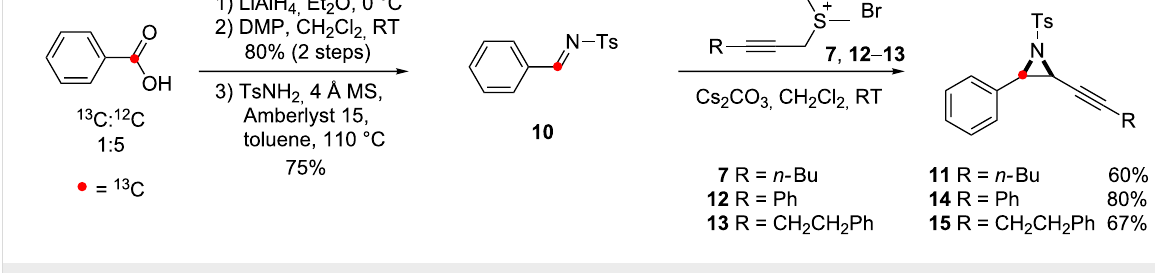
Scheme 6: Preparation of 13 C-enriched alkynyl aziridines.